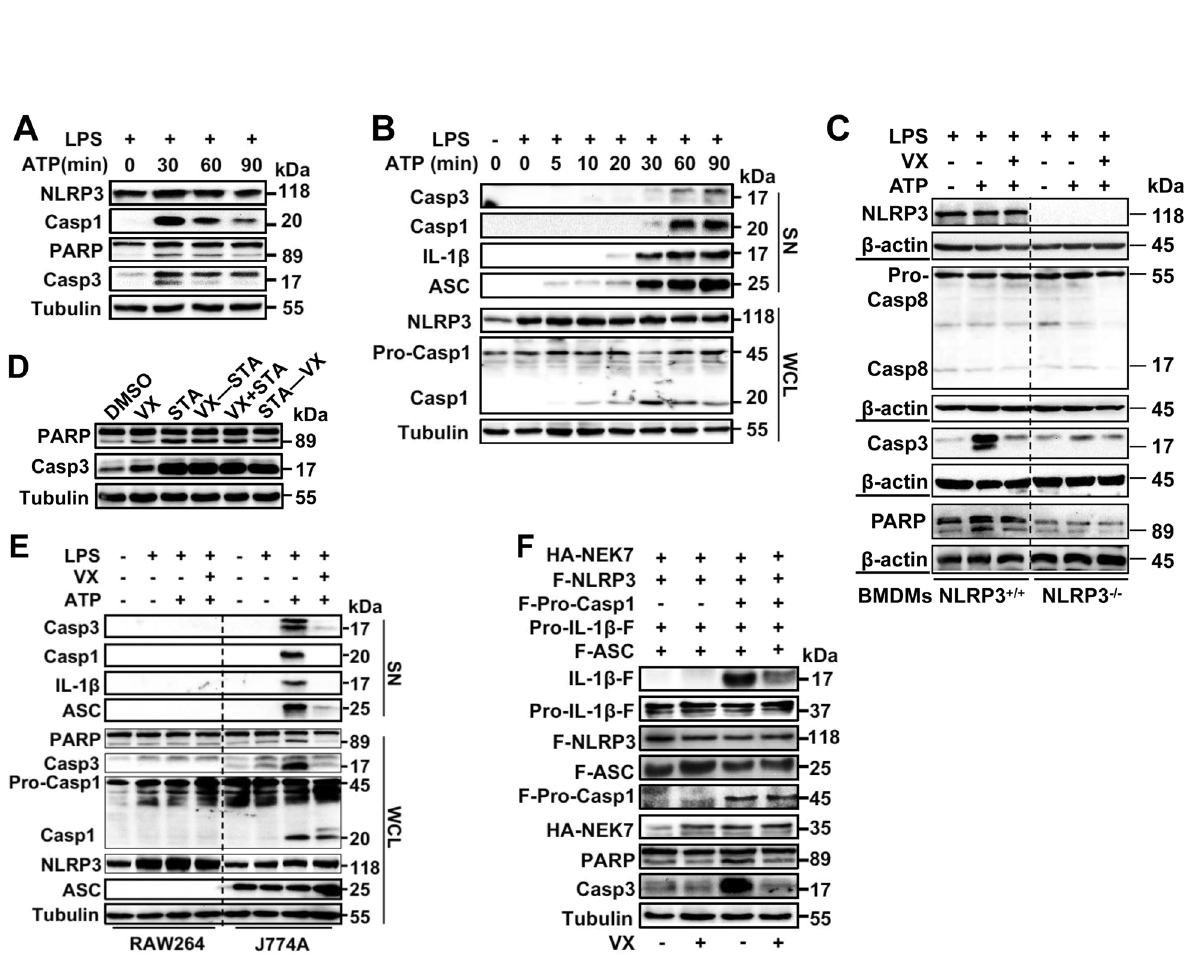
Fig. 3 VX765 impedes macrophage pyroptosis. A , B J774A.1 macrophages were treated with LPS (100 ng/mL, 8 h) and ATP (5 mM) for different time points (0 – 90 min). Cell lysates and supernatants were analyzed by immunoblotting. C Nlrp3 − / − and Nlrp3 + / + BMDMs